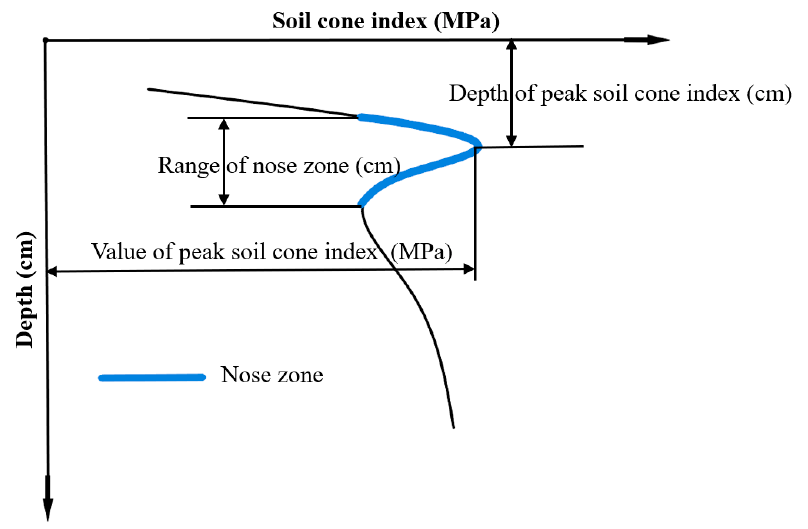
Figure 7. Schematic view of cone index (CI)-related traits.2.4. Profile Meter after the Compaction. The soil deformation was measured during the experiment to study the soil surface deformation in different traction conditions and number of passes. A steel flame combined with a laser rangefinder (Disto Pro, Leica Geosystems AG, Balagah, Switzerland) measured the distance between the flame and the soil surface horizontally every 2 cm, as shown in Figure 8. Data were collected before the first pass, and after 1, 4 and 9 passes. The data collection was repeated three